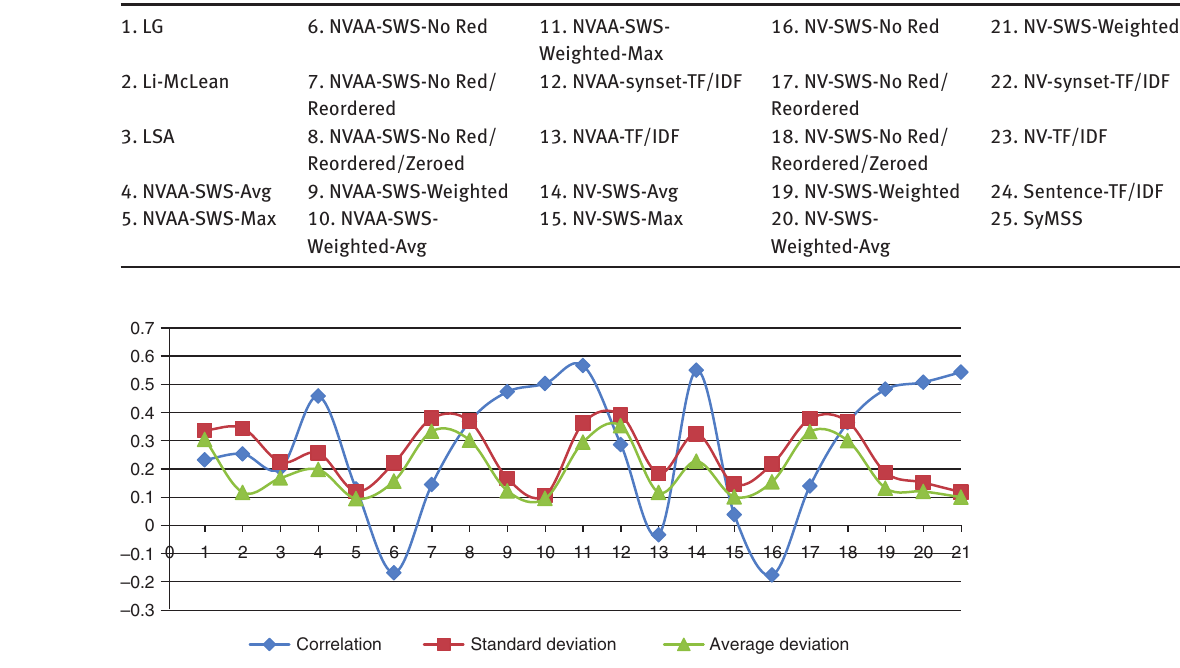
Pearson correlation, standard deviation, and average deviation between the gold score and the calculated score for 21 measures while evaluating the answers. The performance is classified results with respect to gold score, i.e. 0–1, 1–2, 2–3, 34, and 4–5. Finally, Figure 12 shows the overall assessment results, i.e. comparison is made on overall data set of Kaggle data